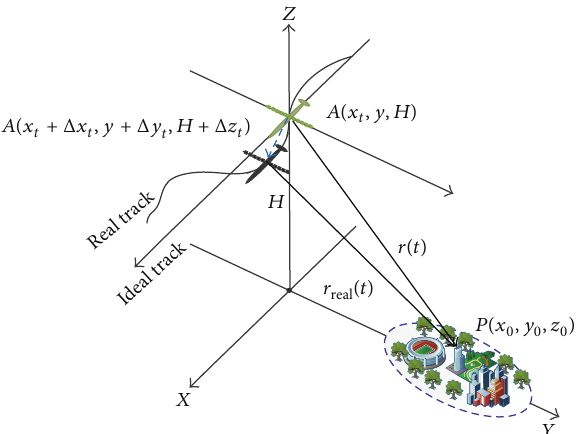
Figure 2: The geometry of MIMO SAR 3D imaging with transla- tional motion errors.